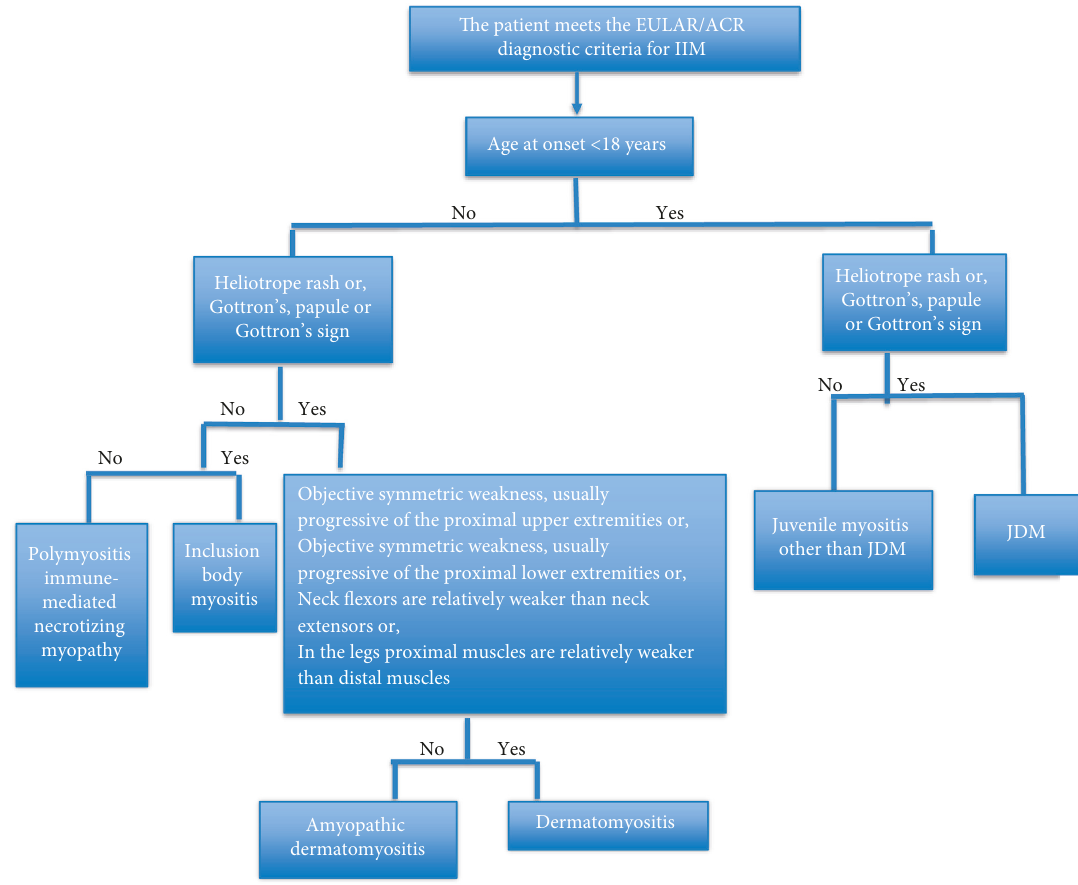
Figure 5: Classification tree for subgroups of IIM